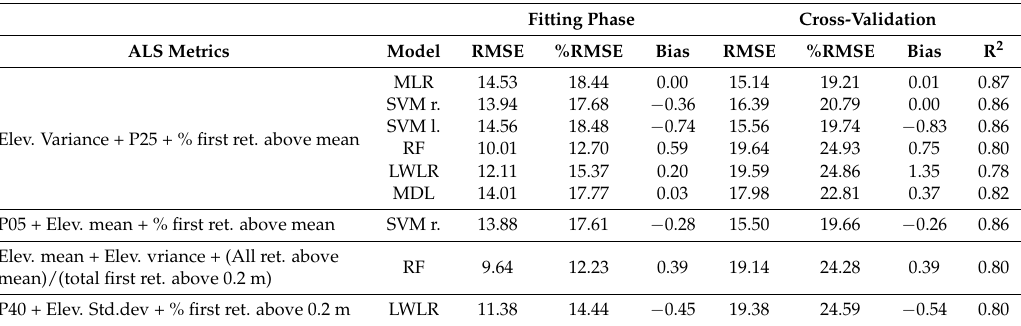
Table 4. Summary of the models and validation results in terms of RMSE (tons/ha), %RMSE, and bias (tons/ha). SVM r. refers to Support Vector Machine with radial kernel; SVM l. refers to Support Vector Machine with linear kernel; ret. is